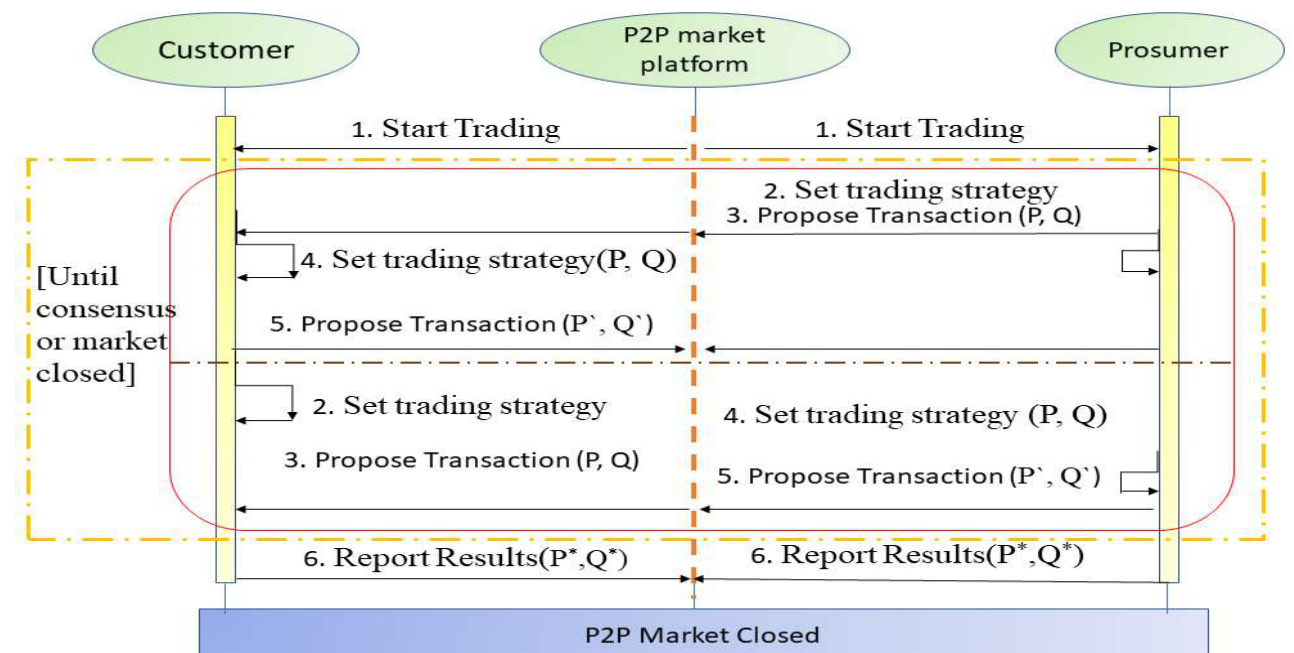
Figure 7. Sequence diagram illustrating asynchronous energy pricing for P2P energy trading. (P, Q: proposed price and volume, respectively; P‘, Q‘: adjusted price and volume according to trading strategy, respectively; and P*, Q*: depicts energy price and volume respectively).